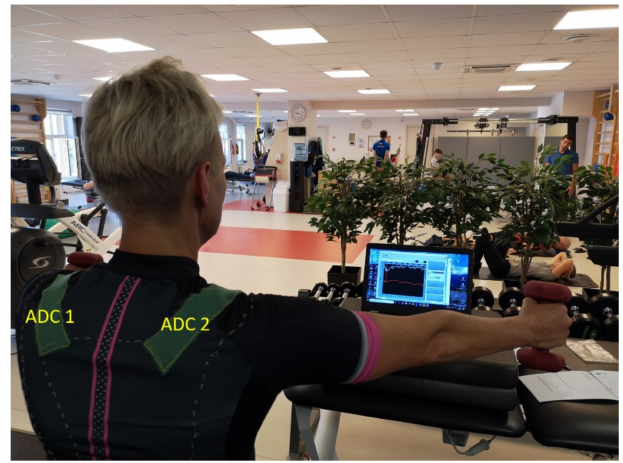
Figure 4. Application of the DAid system during a bilateral arm lift